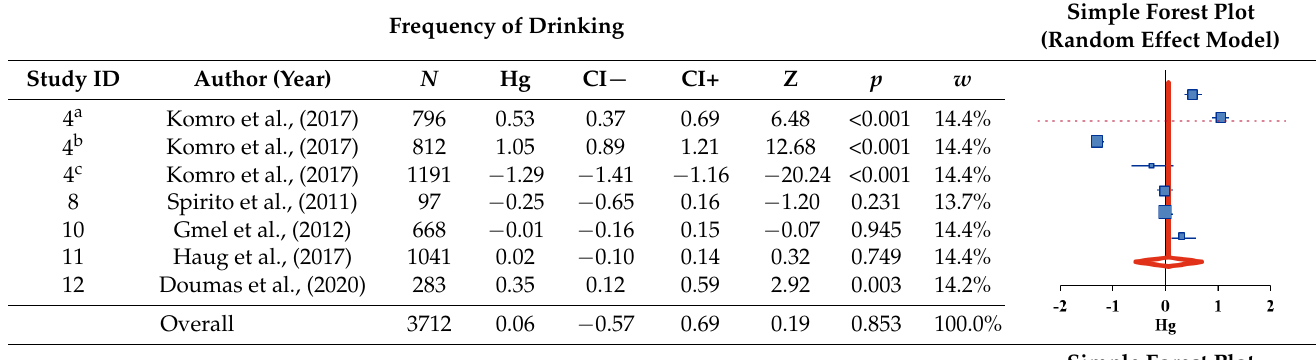
Table 3. Effect size of alcohol prevention interventions on drinking behaviors. Frequency of Drinking